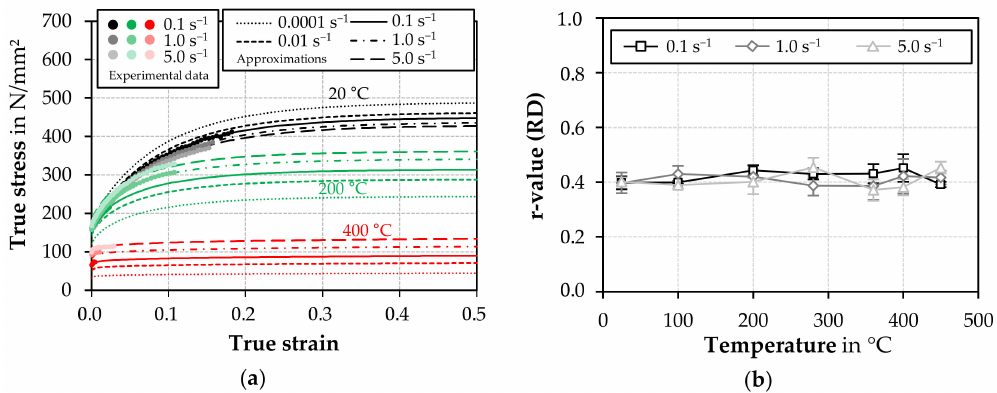
Figure 4. Results of the tensile test at different temperatures and strain rates: ( a ) experimental flow curve data and flow curve approximations for selected test temperatures; ( b ) r-values for different test temperatures and strain rates in rolling direction